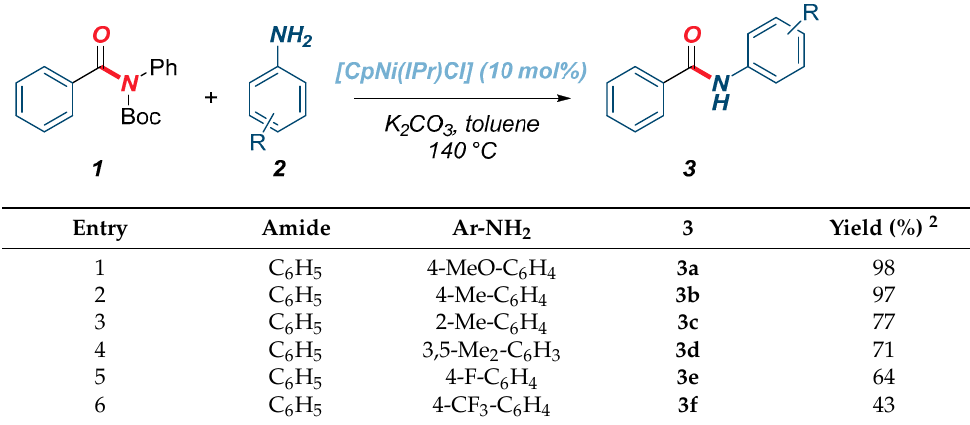
Table 2. Scope of anilines in the transamidation of amide 1a using [CpNi(IPr)Cl]. 1